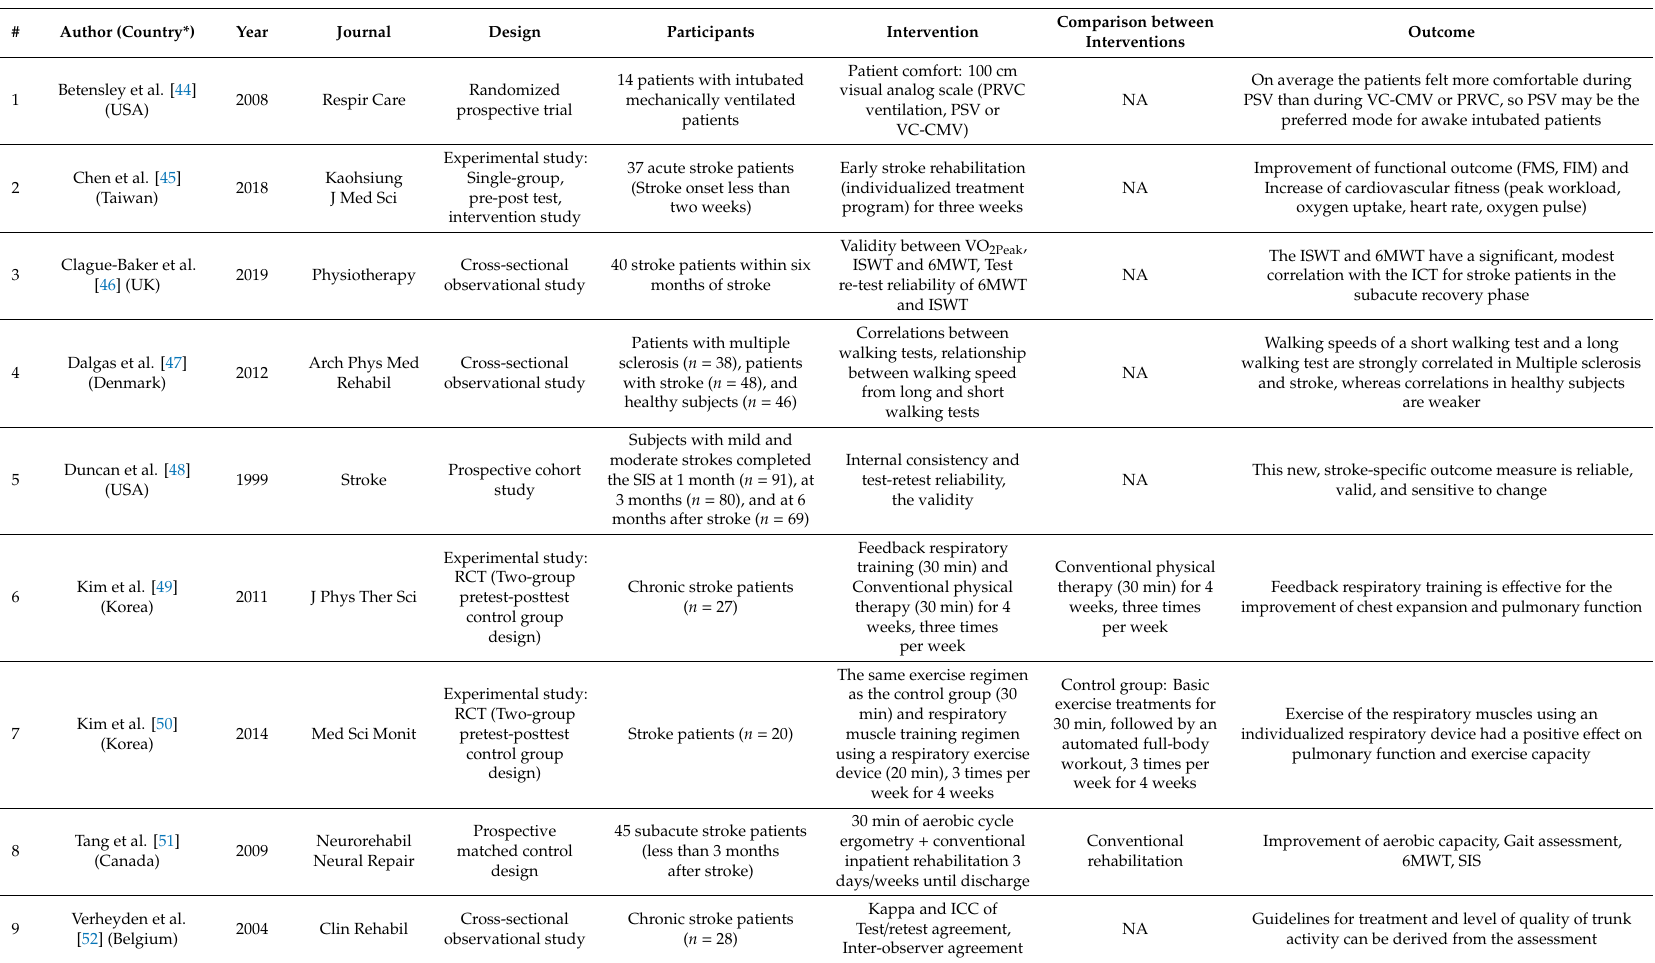
Table 6. Research characteristics selected after the first and second modified Delphi investigations